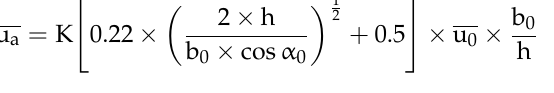
Figure 10. Full set of test results for visual aerodynamic sealing of the air curtain (nozzle thickness). The pictures show that: The average door velocity value increases with the jet thickness.